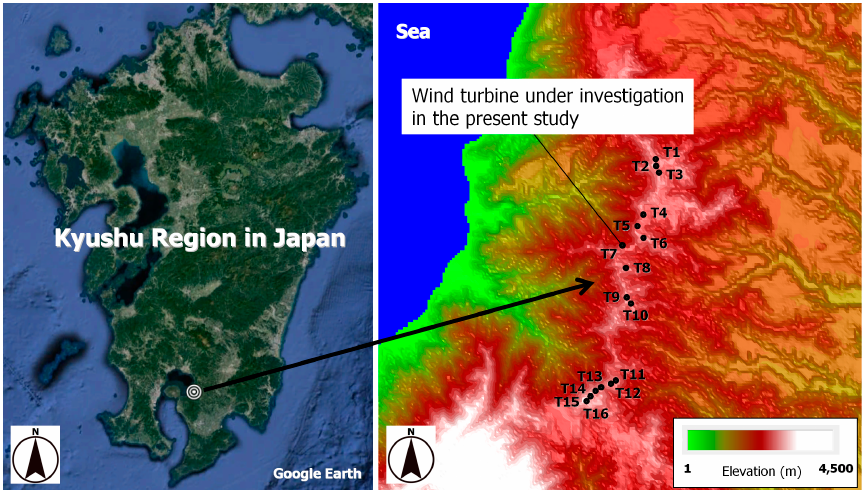
Figure 1. General view of the wind warm under investigation. (T1–T16 indicate the locations of wind turbines #1–#16).